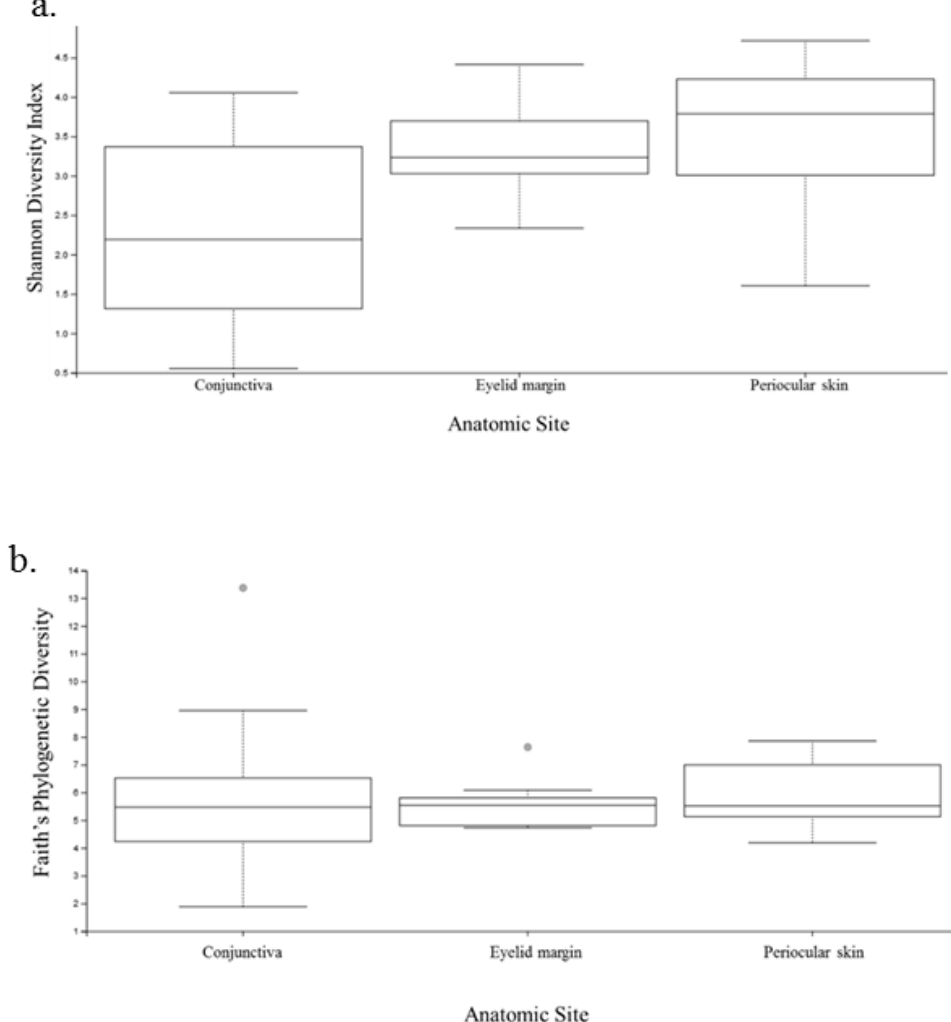
Figure 5. Plots of the diversity indices comparing the conjunctiva, eyelid margin, and periocular skin. ( a ) Shannon index comparing the three anatomic sites. ( b ) Faith’s phylogenetic diversity comparing the three anatomic